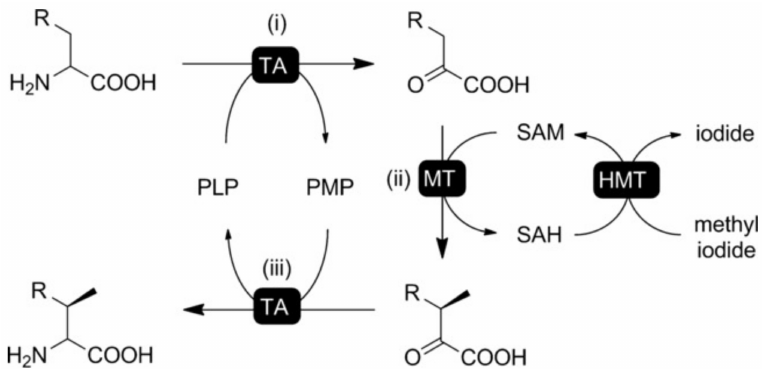
Figure 8. Enzymatic cascade synthesis of β -methyl- α -amino acids. TA: transaminase, MT: methyltransferase, HMT: halide